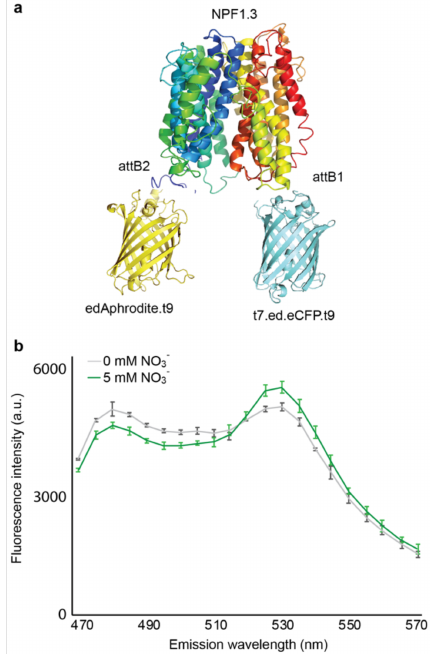
Figure 2. Design and development of the NiTrac-NPF1.3 sensor ( a ). Schematic representation of the NPF1.3 sensor construct. edAphrodite.t9, yellow; t7.ed.eCFP.t9, light blue; NPFs, colors. ( b ). Emission spectra for NiTrac-NPF1.3 expressed in yeast cells; excitation at 428 nm: the addition of 5 mM potassium nitrate (green; control buffer, gray) leads to an emission ratio change triggered by nitrate. Means and s.d. of three biological repeats are presented. Similar results were obtained in at least three independent experiments.